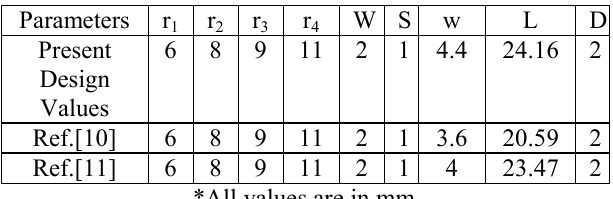
Figure 1 shows the geometry of proposed split semi-horse shoe structure with both rings has vertical split cut in Y-